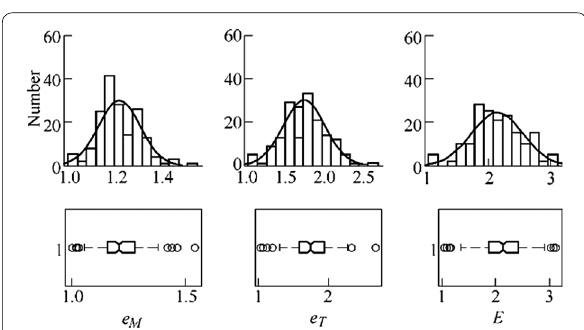
Figure 11 Histograms and box plots for turbocharged diesel groups